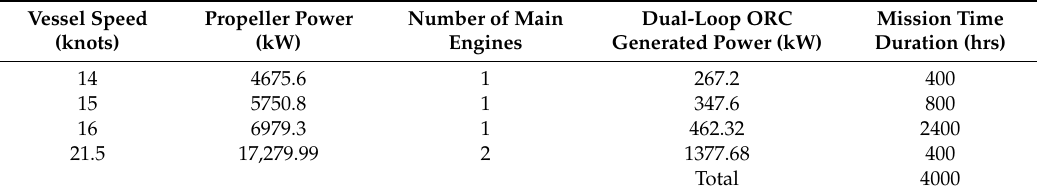
Table 2. Values for propeller power, regenerative dual-loop ORC generated power, and mission time duration of the examined general support vessel.